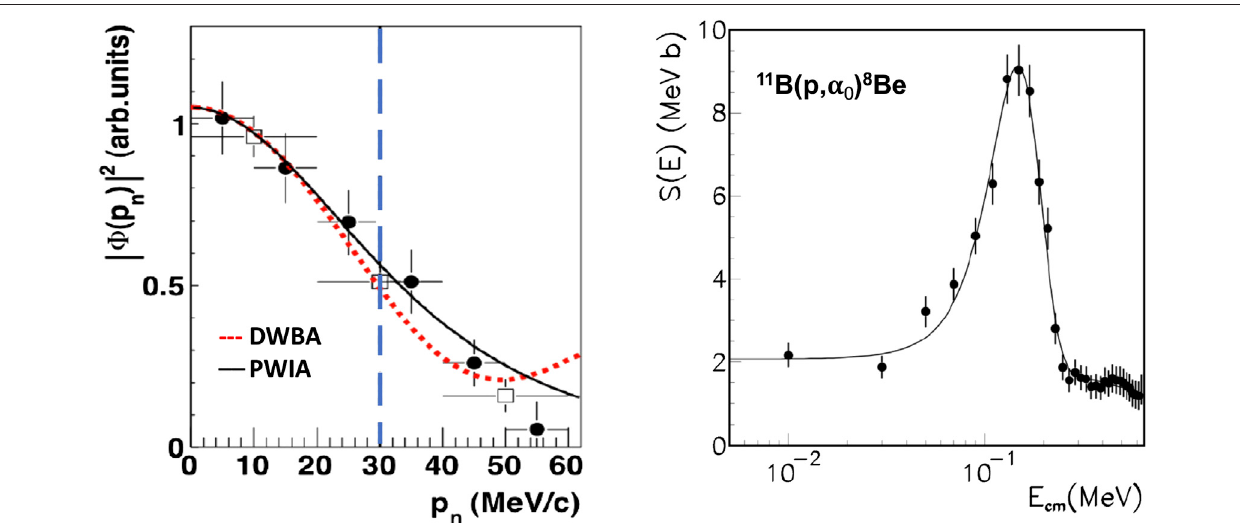
FIGURE 8 | Left panel Experimental momentum distribution of the neutron spectator (black and open points) compared with the Hulthén wave function in momentumspace(black curve)andtheDWBAcalculation(reddashed).Onlythedatawithmomenta lowerthan30 MeV/cwereconsideredfortheanalysis.Rightpanel S(E)-factor for the 11 B(p, α 0 ) 8 Be reaction. Black points represent the THM data while the solid line represents the fi t given in terms of Eq. 8 [Figures adapted from Lamia et al. (2012b)].